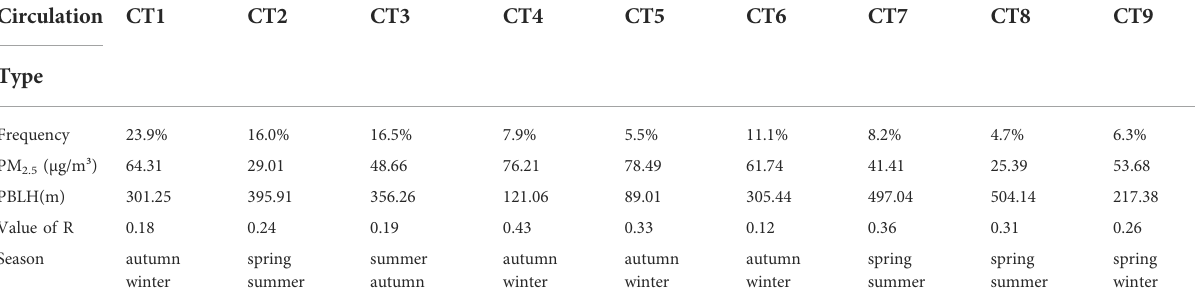
TABLE1Occurrencefrequency,averagePM 2.5 concentration,averagePBLH,averageindex, R ,andfrequentlyoccurringseasonsofthenineCTsinthe CZT